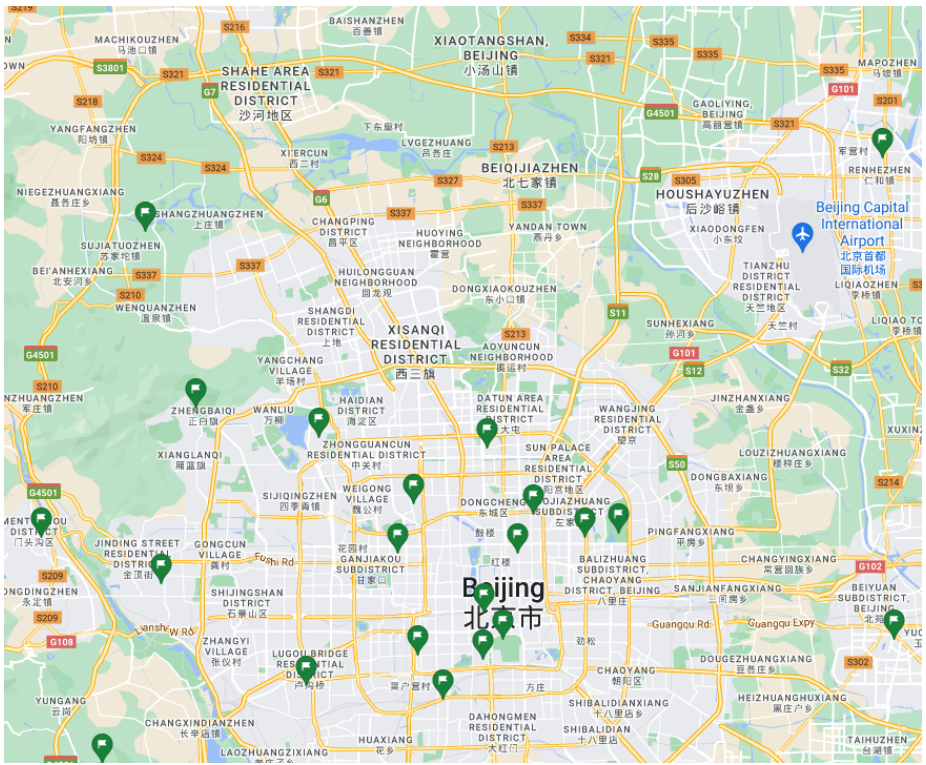
Figure 3. The Beijing map. Each green mark indicates the location of a monitoring stations in